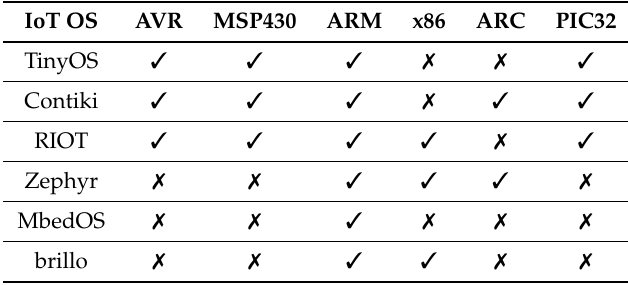
Table 2. IoT OSs Supported